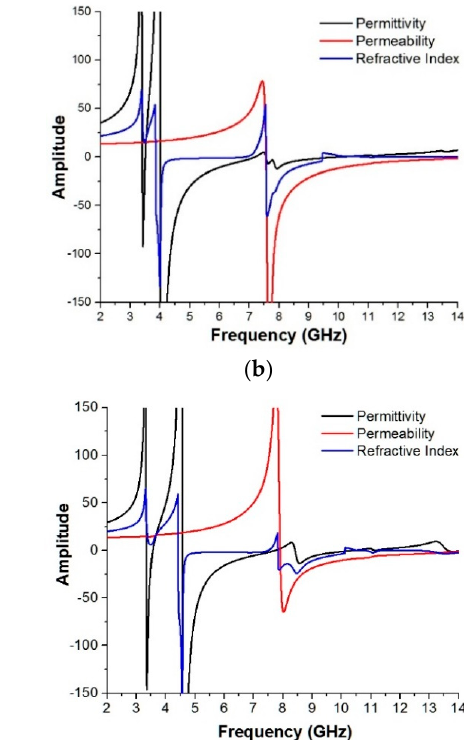
structure appearances as double-negative meta-atoms are shown in Table 3.